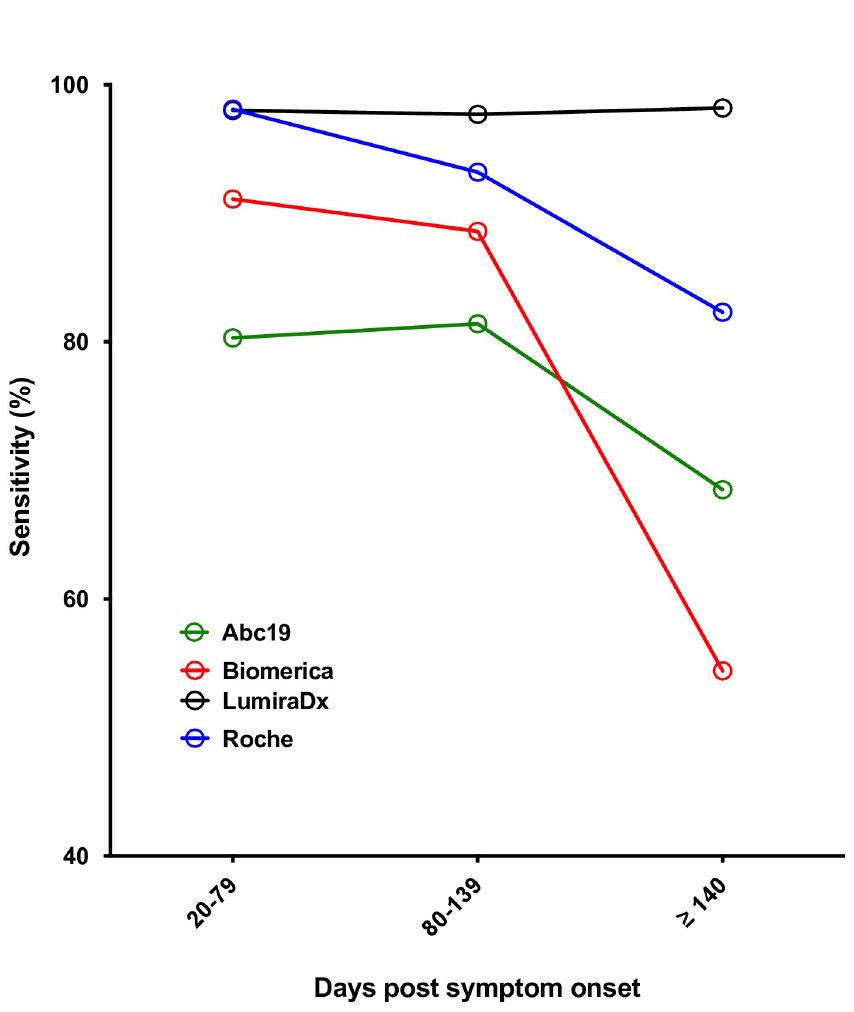
Fig 3. Sensitivity against time post symptom onset. Sensitivity against time post symptom onset for selected kits (IgG for all devices, with the exception of LumiraDX, where overall antibody result was used).